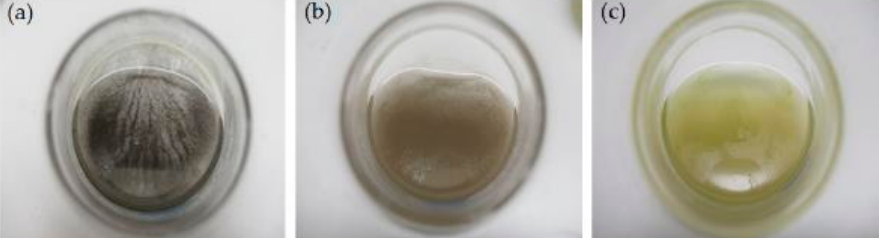
Figure 5. Precipitation of AgNPs at the bottom of the Erlenmeyer flaks (top view) after 24 h of reaction with AgNO 3 : ( a ) LCFM-1.250 mM; ( b ) LCFM-0.625 mM; and ( c ) LCFM-0.125 mM. Table 1. The presence of available biological sources in the different biosynthesis routes. Route Available Biological Sources of Reducing and Stabilizing Agents Whole Cells Free EPS